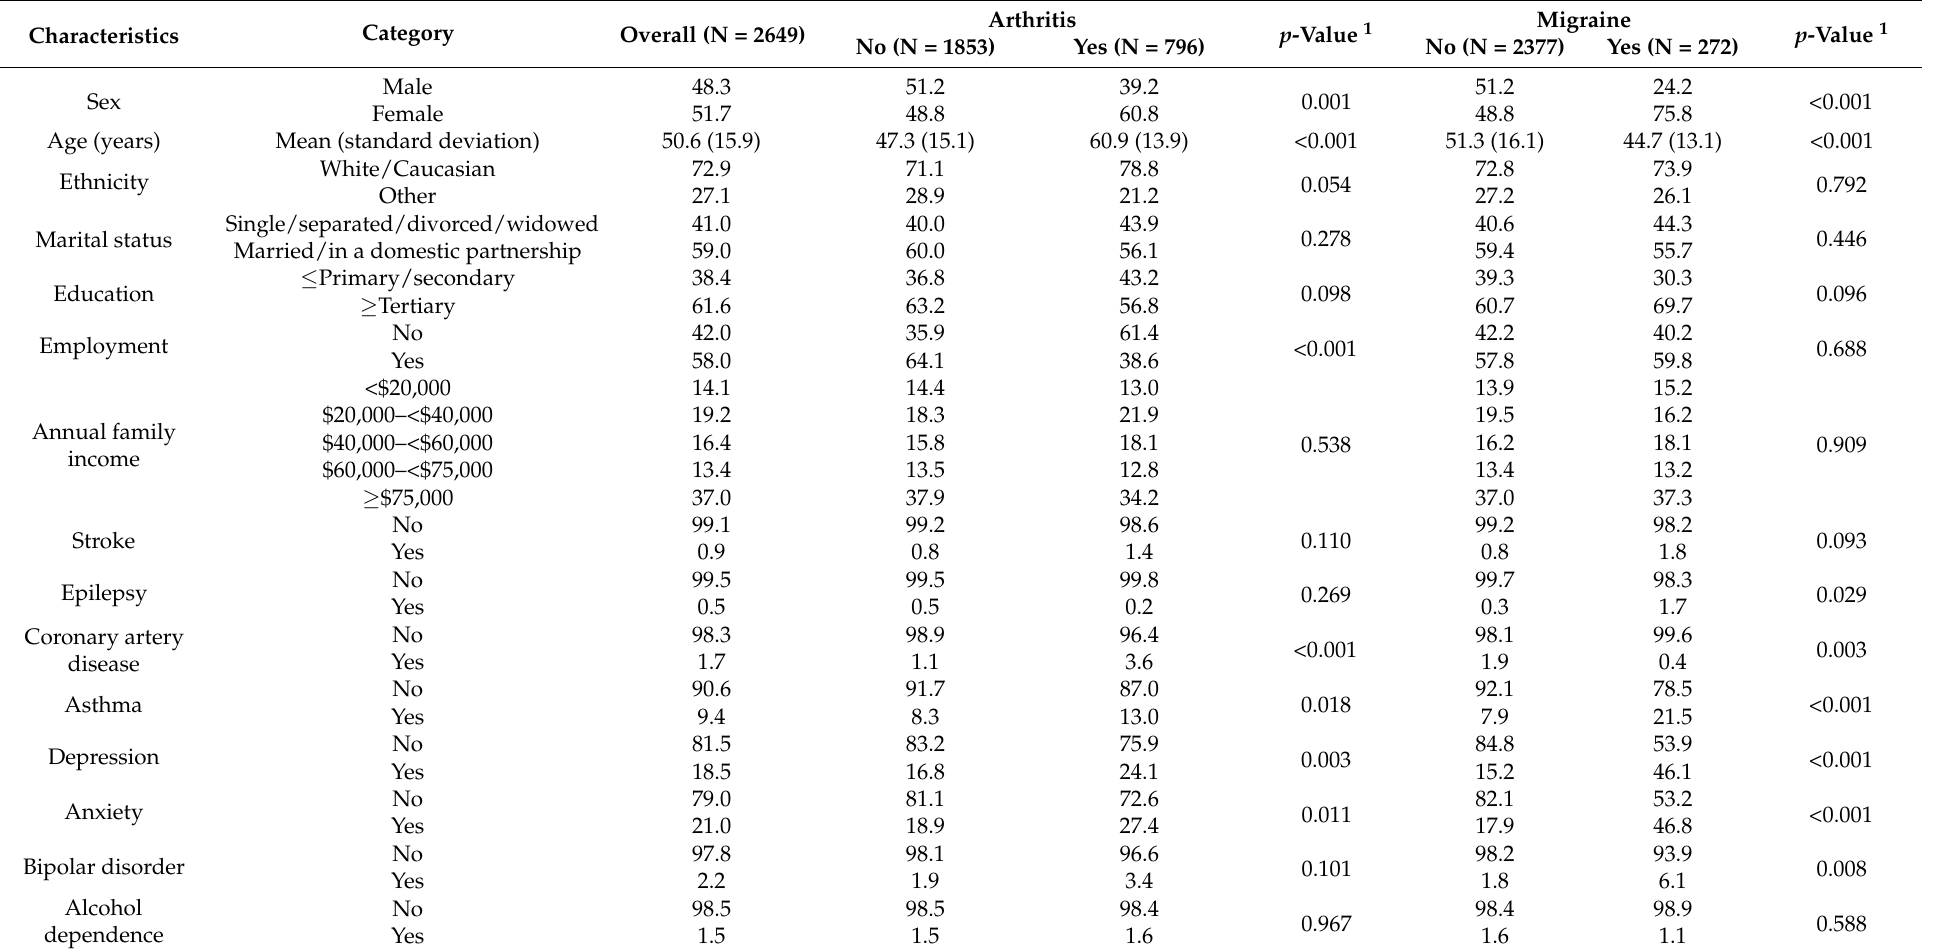
Table 1. Sample characteristics (overall and by arthritis and migraine